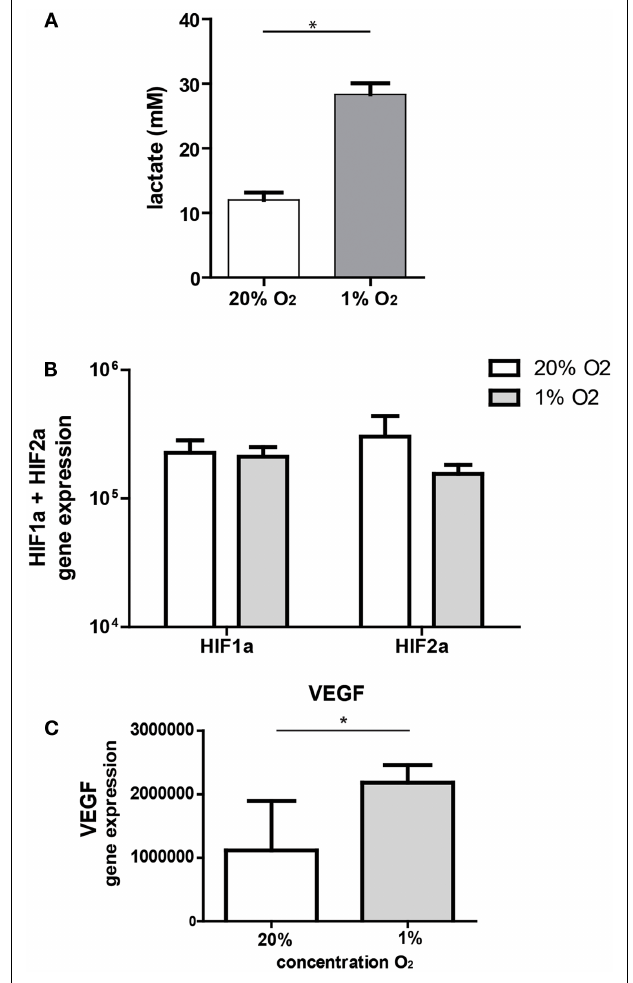
FIGURE 1 | (A) Lactate production by ASC. ASC were cultured under 20 or 1% O 2 for 3days and medium collected for lactate measurements. Mean with SEM of three experiments is shown. (B) Effect of hypoxia on gene expression of hypoxia-inducible genes; mRNA expression of HIF1- α and HIF2- α by ASC after 24h culture under normoxic (20% O 2 ) and hypoxic (1% O 2 ) conditions. Mean with SD of four different experiments is shown. (C) mRNA expression ofVEGF, downstream of HIF1- α under normoxia and hypoxia. Mean with SD of four different ASC cultures, *Indicates p <